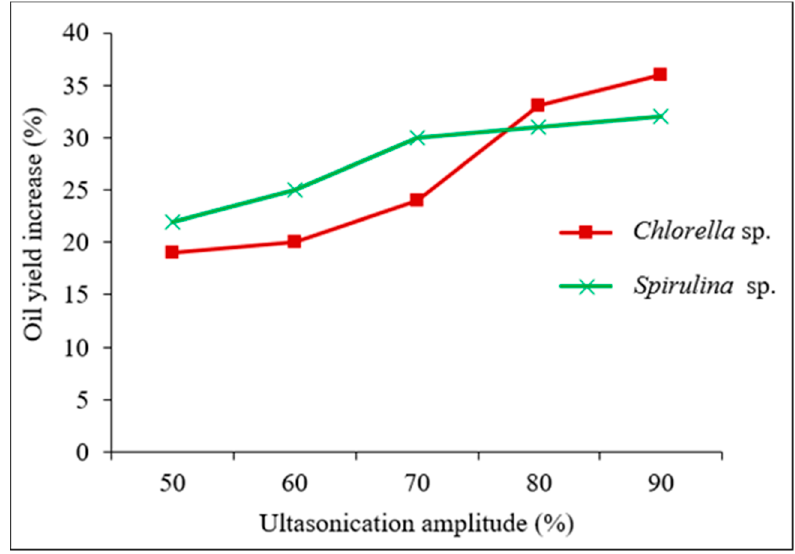
8 of 19 Table 1. Comparison study of the percentage oil yield based on different extraction methods. Species